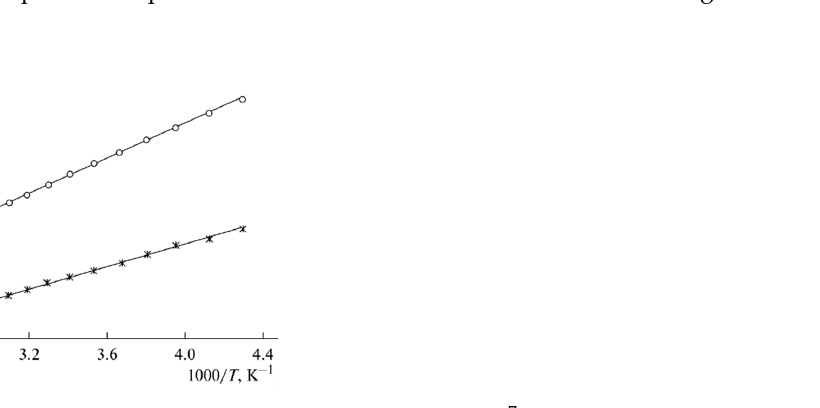
Figure 16. Temperature dependences of the correlation times of 7 Li + in PGE nos. ( 1 ) 2 and ( 2 ) 9 [53]. Assuming that the size of a solvated cation l is about 0.5 nm from the Einstein rela- tionship ( D Li = l 2 /6 τ c ), the calculated values are 1.5 × 10 –6 cm 2 /s for the sample with the maximum solvent content (no. 9) and 4 × 10 –8 cm 2 /s for sample no. 2 (minimum EC con- tent).